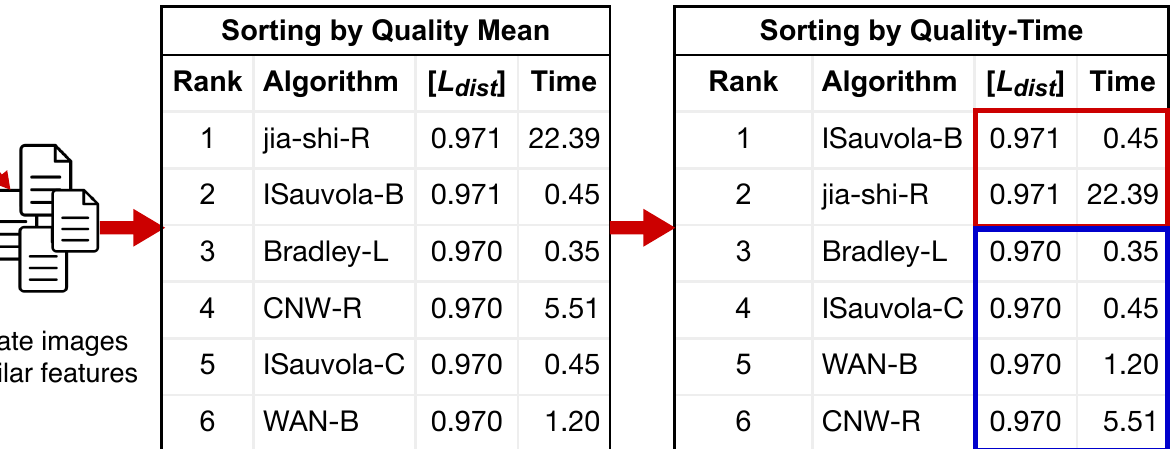
Figure 3. Example of ranking by the quality-time criteria. The algorithms are first sorted by quality ( [ L dist ] ) and then by time. The red and blue boxes highlight that the first two algorithms have the same quality results and thus are sorted separately from the other four.